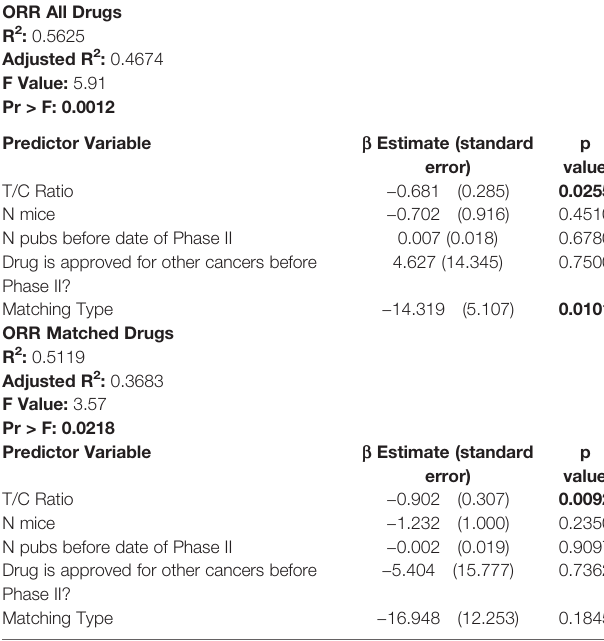
TABLE 4 | In multivariate analysis, only T/C ratio is independently associated with objective response rate (ORR) in matched and unmatched drug-indication pairs. ORR All Drugs R 2 :